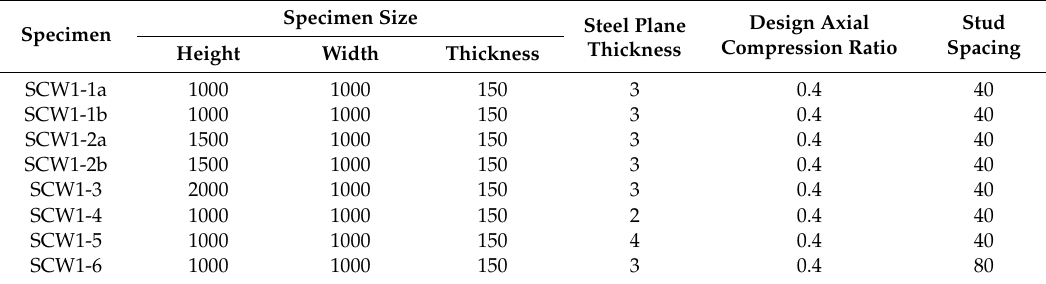
Table 2. The parameters of